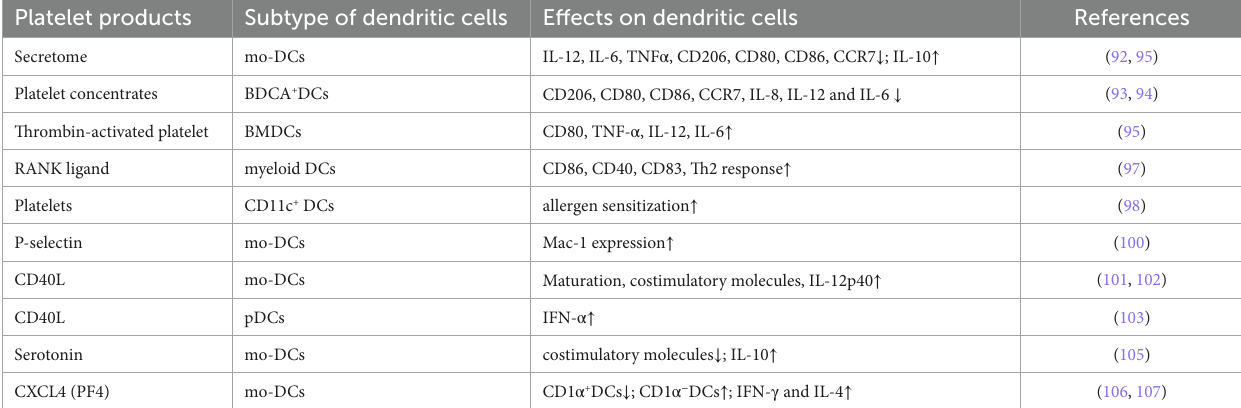
TABLE 3 Platelet-derived molecules affect the function and differentiation of dendritic cells. Platelet products Subtype of dendritic